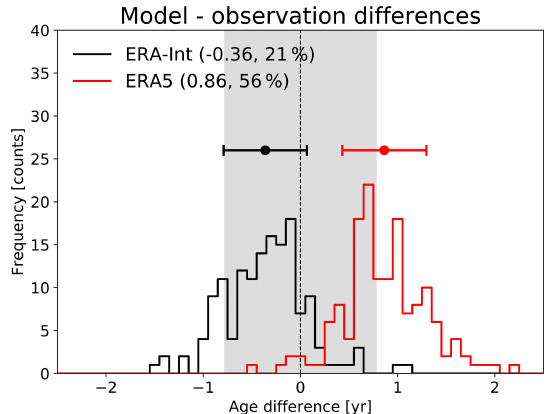
Figure 11. Difference in mean age between model and Geophys- ica aircraft observations for ERA5 (red) and ERA-Interim (black). Shown are frequency distributions of the mean age differences (bin size of 0.1 year) taken in the extratropical lower stratosphere, about 350–480K (for details on the measurements, see Laube et al., 2020). The grey shading shows the mean uncertainty range of the observations ( ± 0 . 78 years), the red and black symbols show the mean differences, and the error bars show their standard deviation (1 σ ) range. The numbers in the legend are the mean difference val- ues (in years) and the percentage of data outside this uncertainty